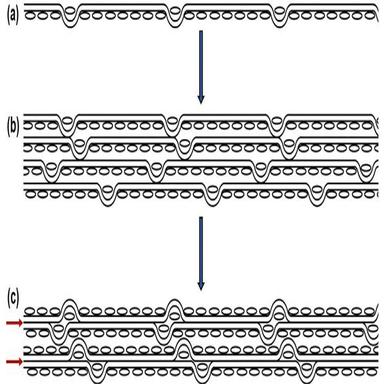
(a) Side-on view of a single sheet of woven eight-harness satin weave; (b) stacking of multiple sheets without rotation - every longitudinal tow shows contact with both the ones above and under it; (c) stacking of multiple tows with alternating orientation - layering is highlighted with red horizontal arrows.